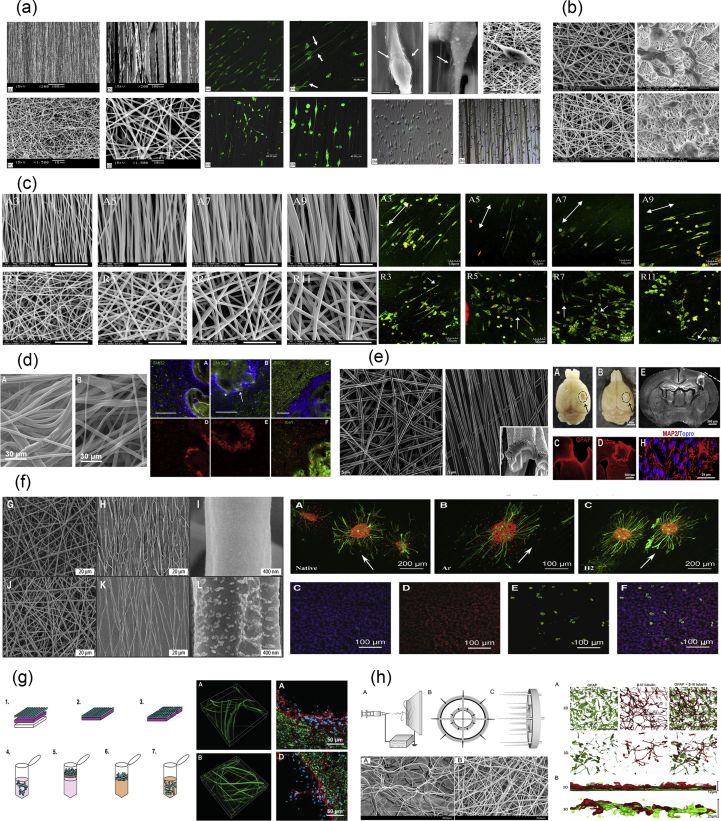
Use of electrospinning for the creation of fibrous scaffolds for central nervous system regeneration. (a) electrospun PLLA microfibers and nanofibers for neural stem differentiation [168], (b) aligned nanofibers made of PCL/gelatin copolymer support adhesion and proliferation of neural cells [170], (c) PLLA nanofibers direct neurite outgrowth of C17.2 cells [172], (d) aligned PCL nanofibers encapsulated with a non-peptide ligand were implanted in the rat brain [173], (e) lactate-releasing 3D electrospun PLA nanofibers implanted in the rat brain to support neurogenesis [174], (f) electrospun polyether-based PU nanofibers with surface modification [175], (g) hybrid scaffolds composed of electrospun PLLA/fibronectin fibers and hydrogels injected into the rat brain [176], and (h) fabrication of uncompressed low-density electrospun PCL fiber scaffolds using a custom-made rotating collector for 3D cell assay with human neural progenitor cells [177]. Images adapted with permission from (a) Yang et al. ​[188], (b) Ghasemi-Mobarakeh et al. ​[170], (c) He et al. ​[172], (d) Fon et al. ​[173], (e) Alvarez et al. ​[174], (f) Zanden et al. ​[175], (g) Rivet et al. ​[176], and (h) Jakobsson et al. ​[177]. PLLA, poly-l-lactic acid; PCL, polycaprolactone; 3D, three-dimensional; PLA, polylactic acid; PU, polyurethane.